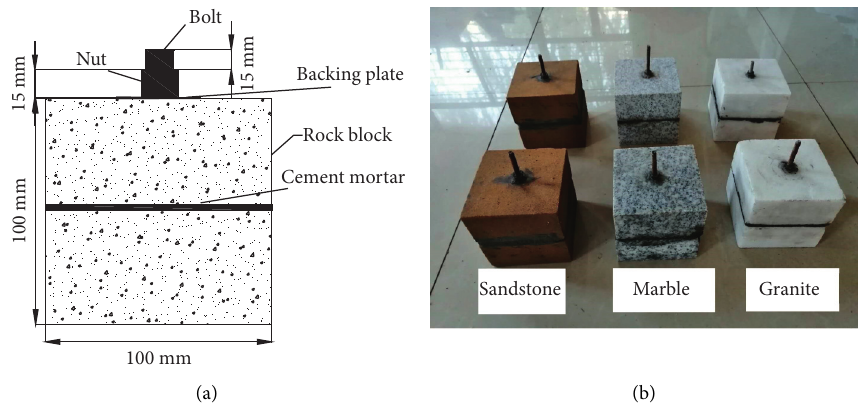
Figure 1: Test pieces. (a) Specimen model diagram. (b) Physical drawing of the specimen.